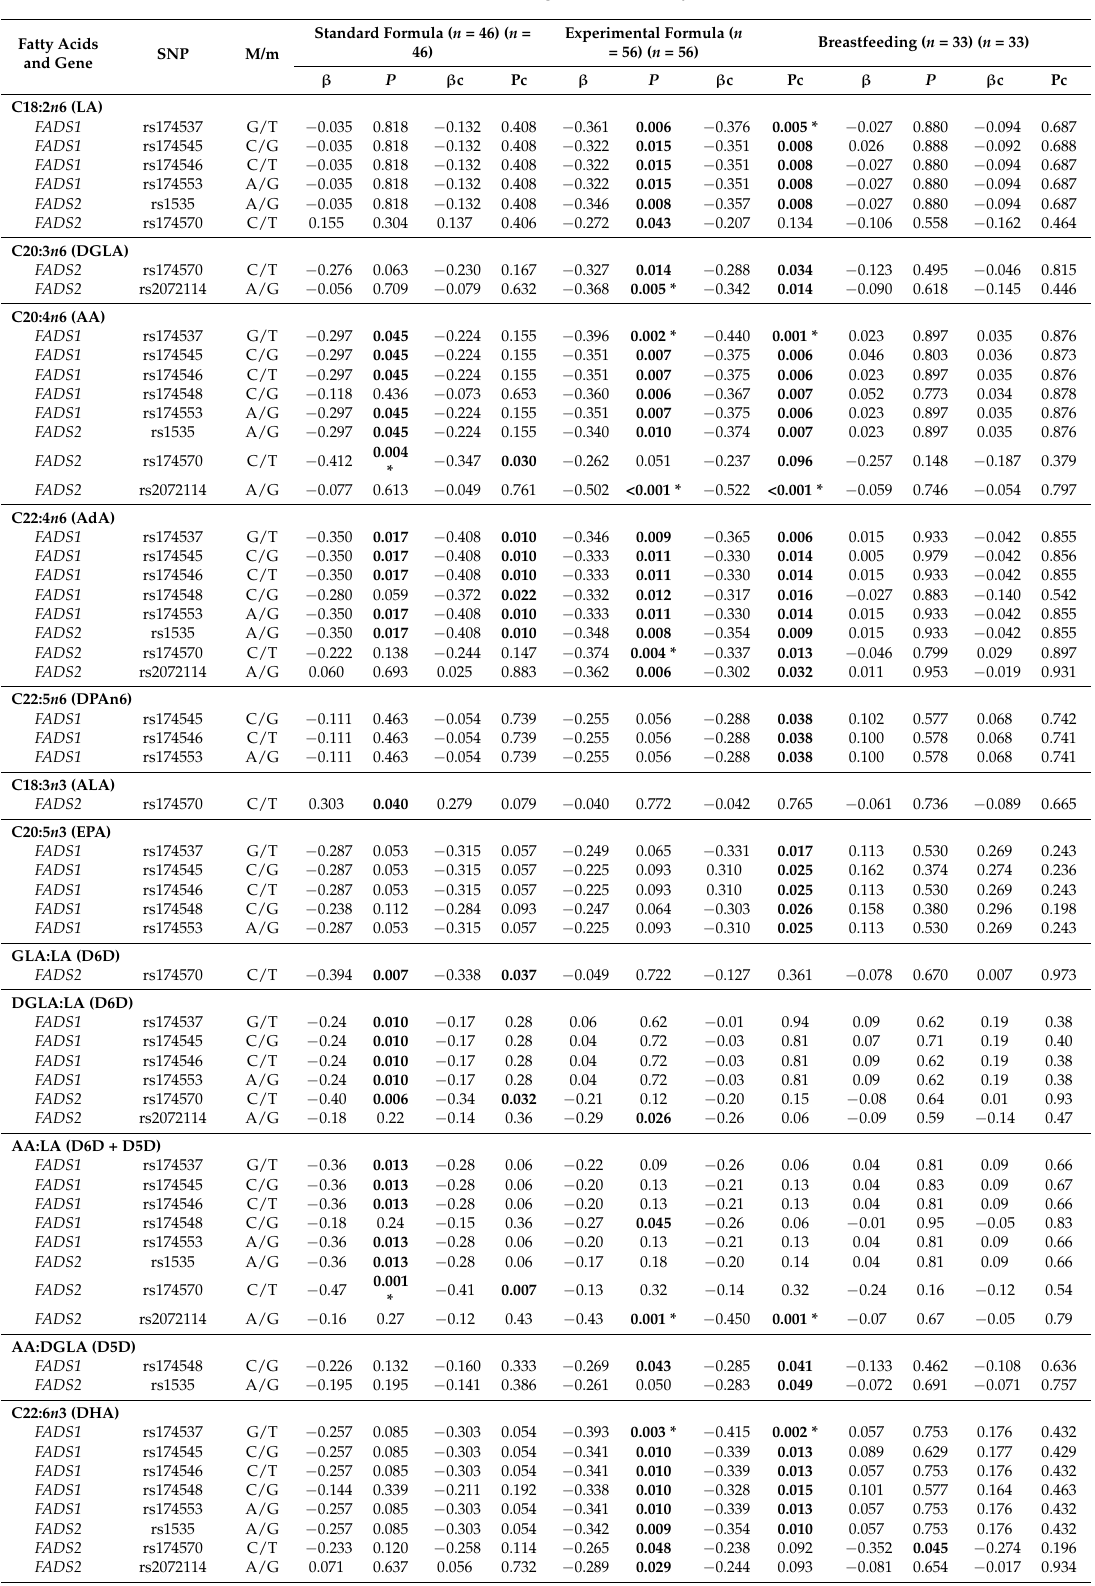
Table 3. Associations between FADS genes and fatty acids levels in